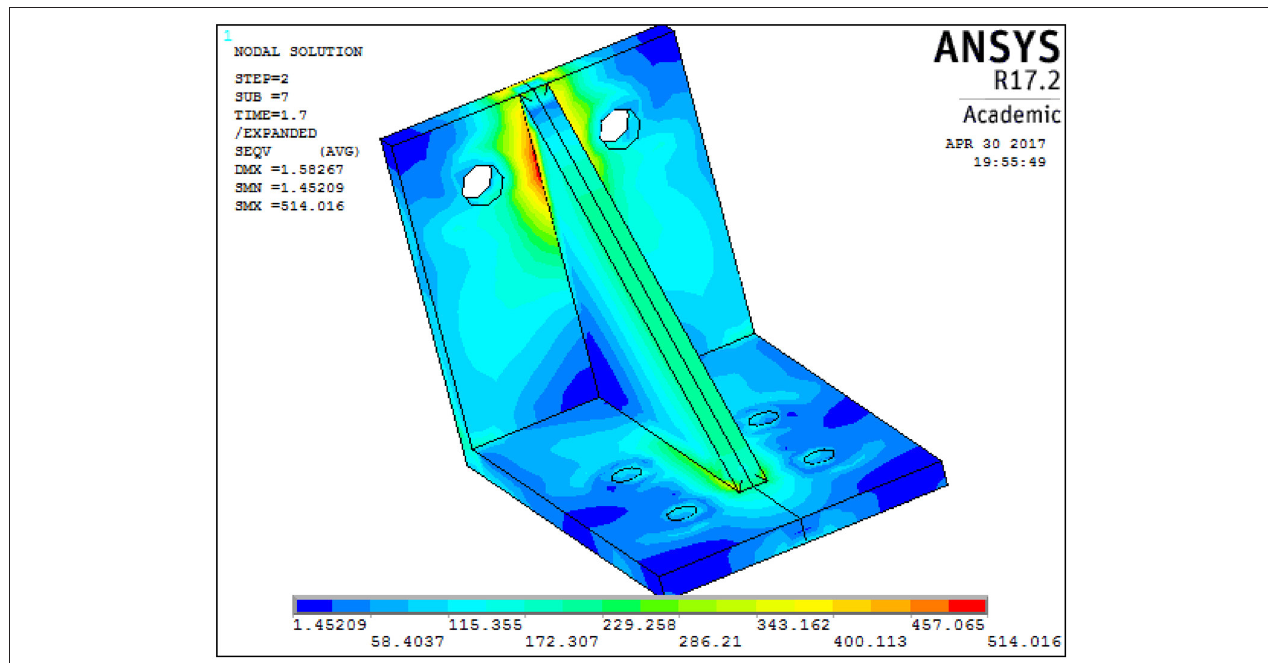
FIGURE 10 | Von Mises stress distribution in the top angle for case